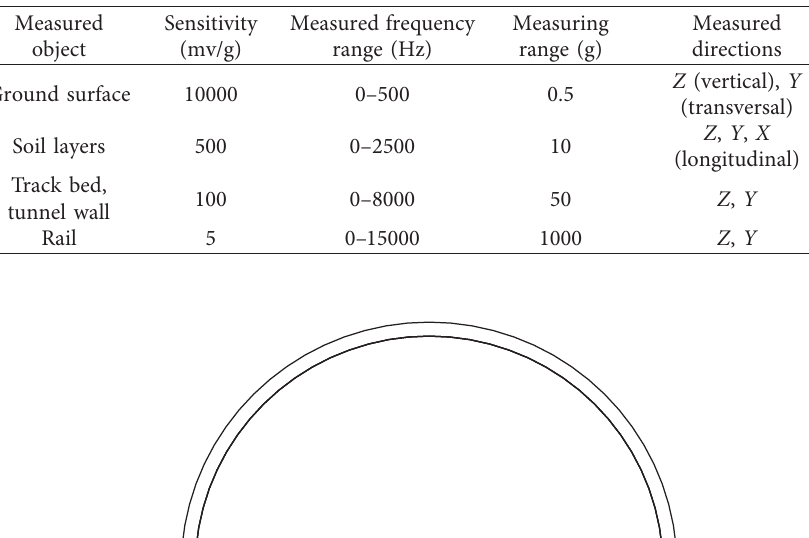
Table 2: The main technical index of different accelerometers.